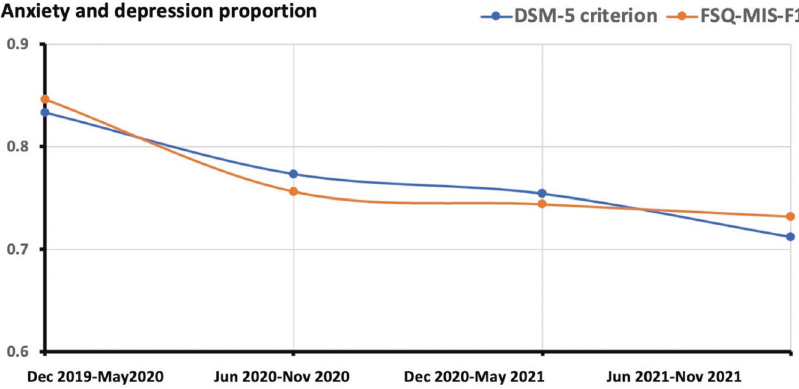
Fig. 2 General loglinear analysis of anxiety and depression in the four COVID-19 stages. FSQ-MIS-F1 = Factor1 of the fast-screening questionnaire for mental illness symptoms. The results show that the anxiety and depression decreased with the relief of the pandemic in China mainland, and the FSQ-MIS exhibits high parallel validity with